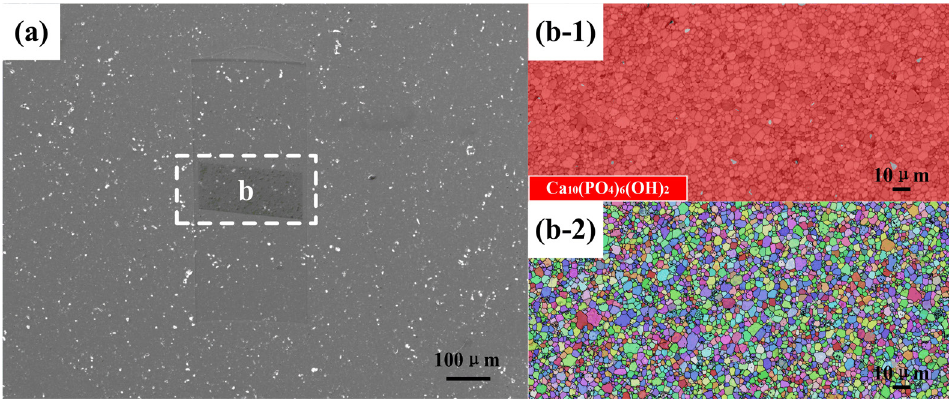
Figure 4. ( a ) SEM morphology; ( b-1 ) phase distribution; and ( b-2 ) inverse pole figures of pure HA sintered at 1250 °C.